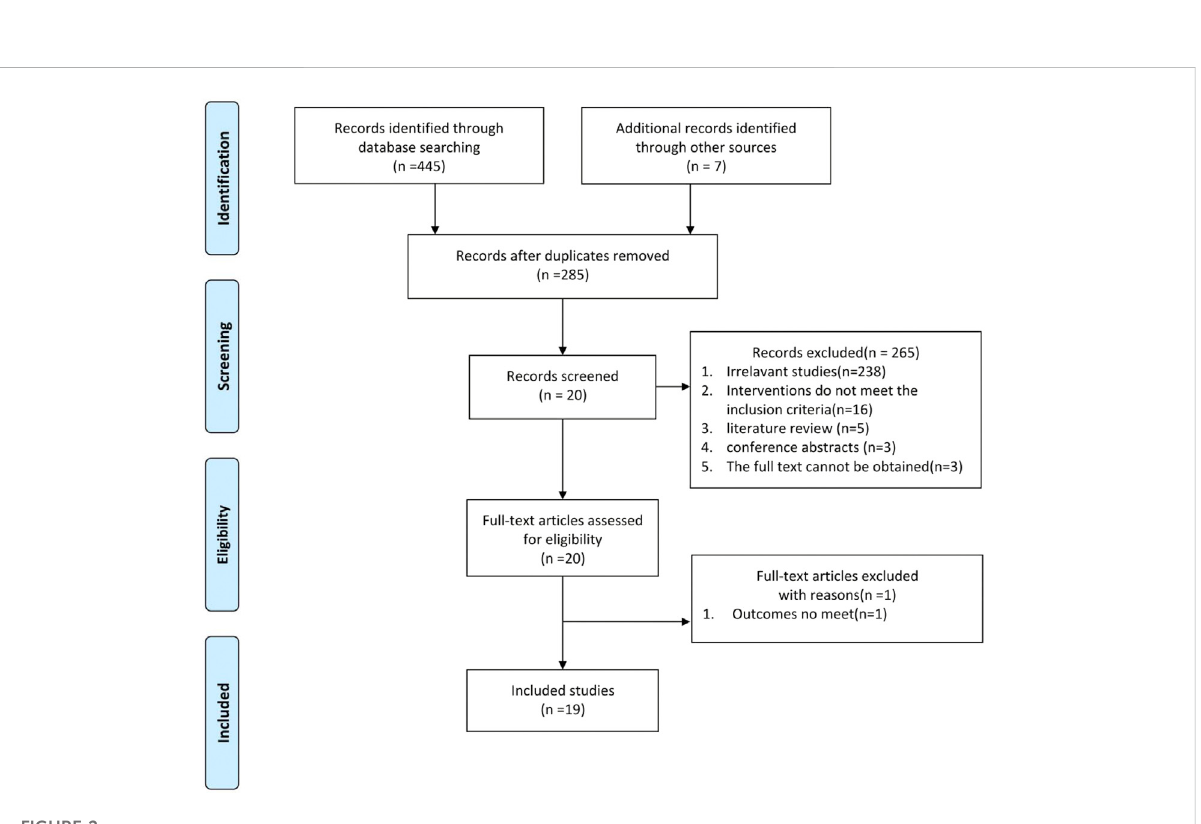
FIGURE 2 Flow diagram of the study-search